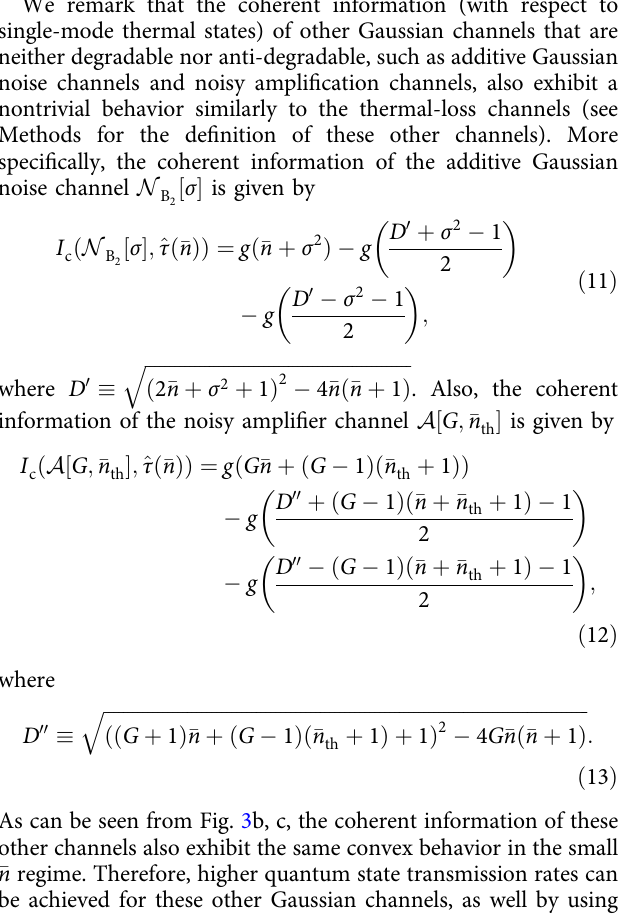
ðN ½ η ; (cid:2) n (cid:2) ; ^ τ ð (cid:2) n ÞÞ (blue rc th